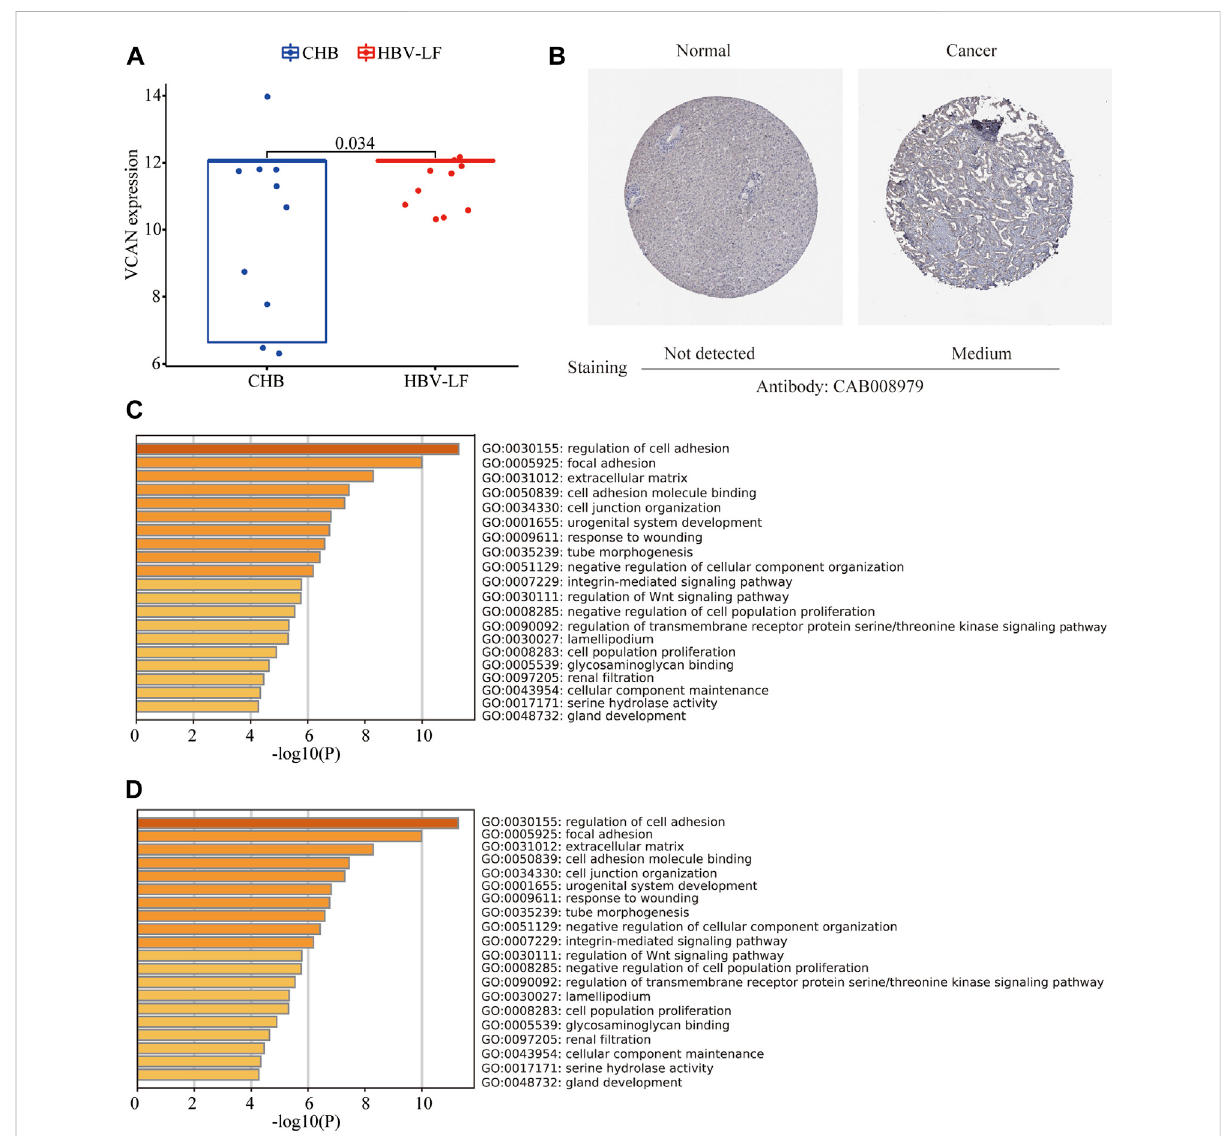
FIGURE 7 VCAN expression in HBV-LF and enrichment analysis of similar/interactive genes of VCAN. (A) The expression level of VCAN between the CHB and LF in the validation set. (B) The immunohistochemistry staining images of VCAN from the HPA. (C) GO analysis of similar/interactive genes of VCAN in Metascape database. (D) KEGG analysis of similar/interactive genes of VCAN in Metascape